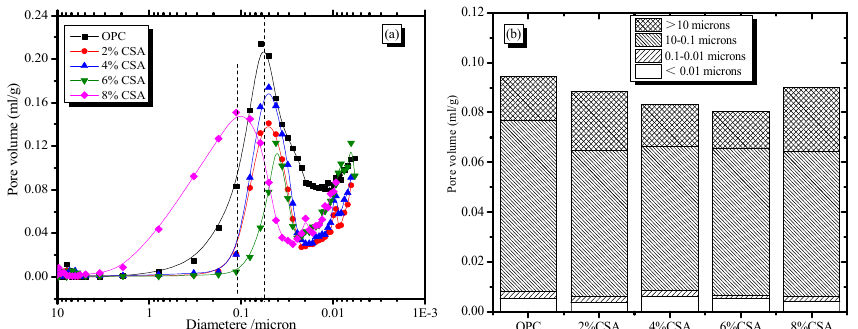
Figure 12. Effect of CSA cement on the pore structure ( a ) Pore size distribution of cement pastes, ( b ) The percentage of pore with different size.